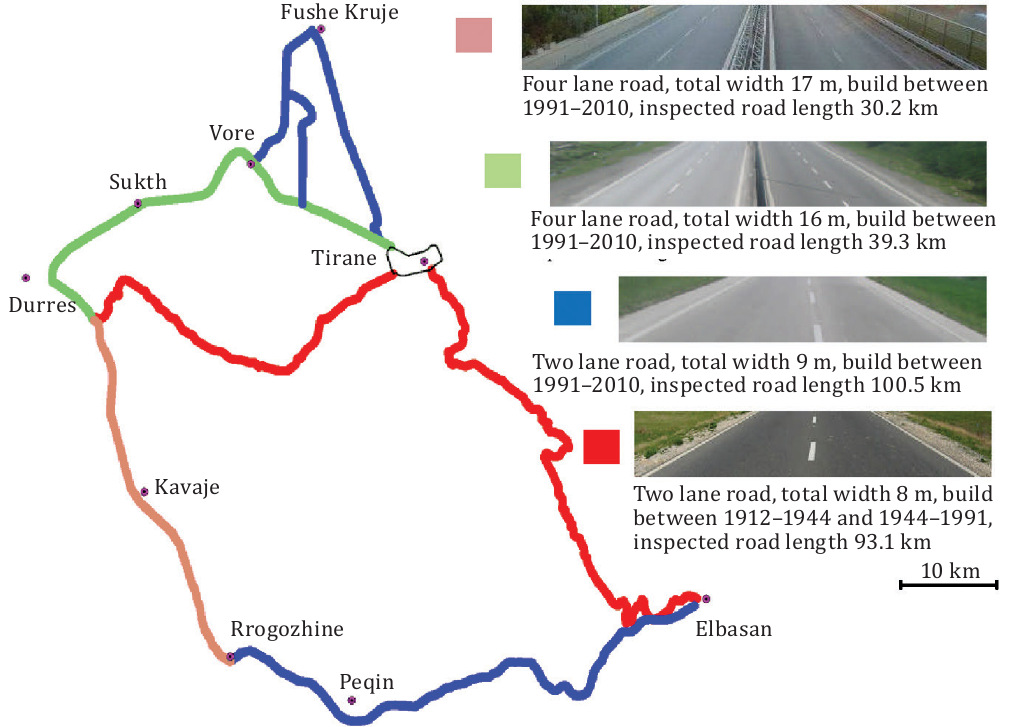
Figure 2. Inspected road